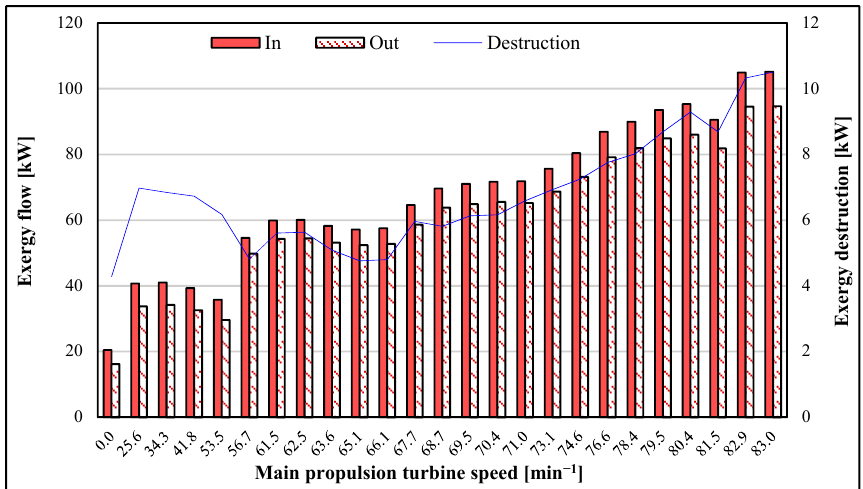
Figure 4. Exergy flow of atmospheric drain tank with main turbine load variation.